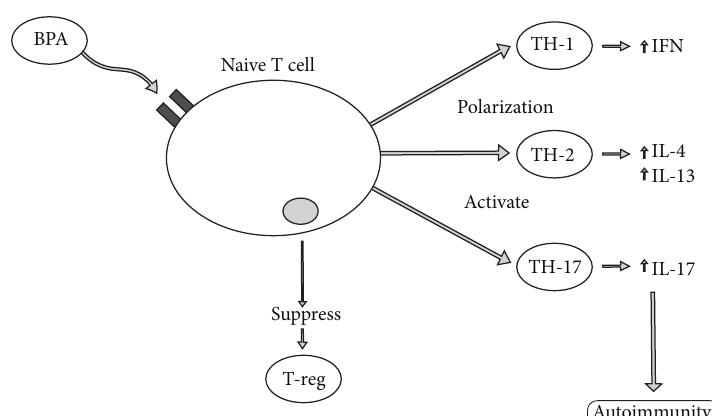
Figure 7: This diagram illustrates how bisphenol A can induce T cell shifts, promoting autoimmunity. BPA: bisphenol A; IFN: interferon; IL: interleukin; TH: T-helper; T-reg: regulatory T cell.